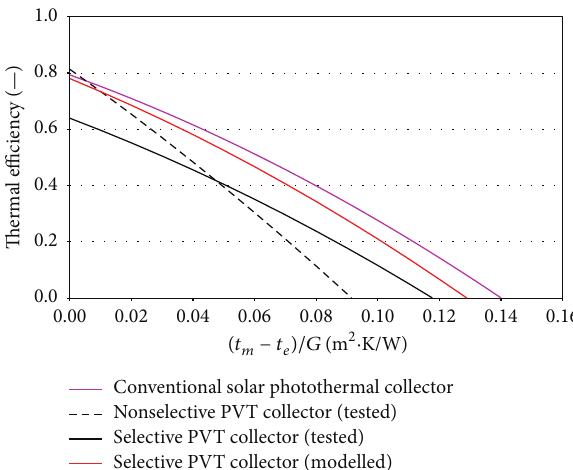
Figure 4: Thermal efficiency characteristics of PVT collectors used in analysis (under MPPT electric